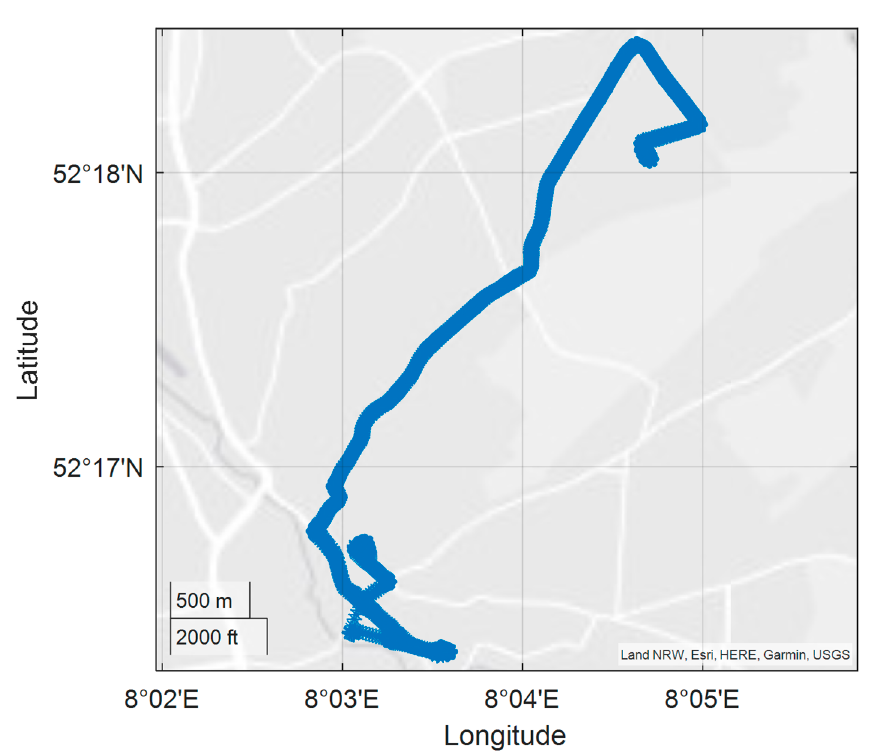
Figure A2. Route map of N5 for the demonstration.